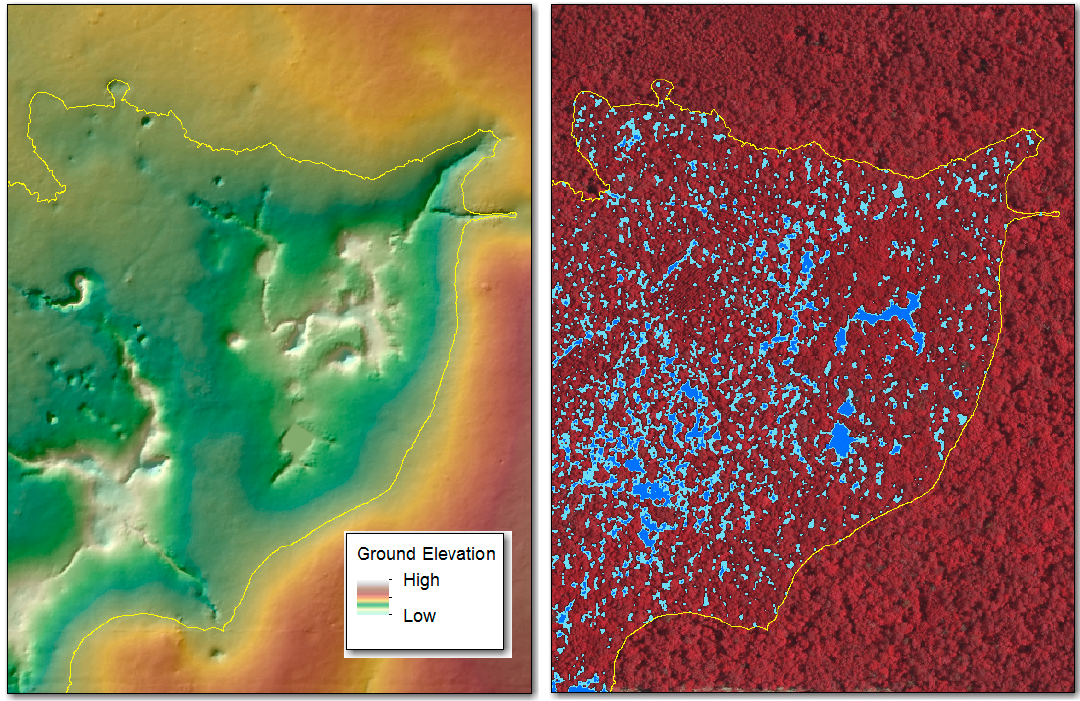
Figure 7. Comparison of Tropical Storm Debby modeled floodplain (yellow outline) to the DEM ( left ) and results ( right , indicated in blue) of the fCIR image analysis (scale ~ 1:10,000).